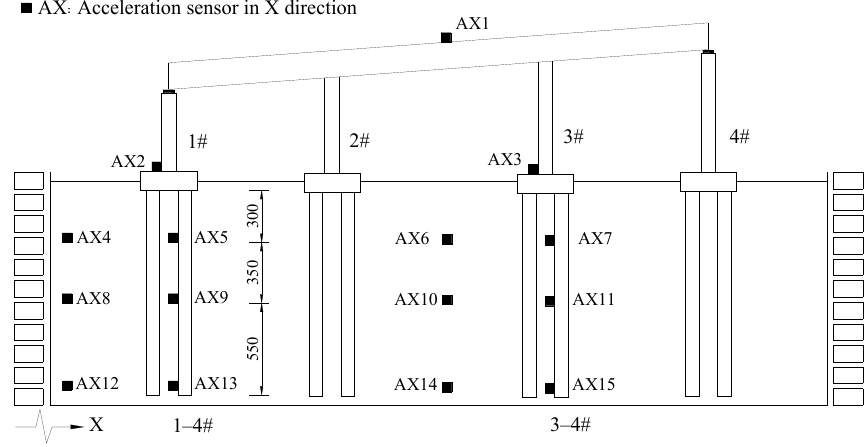
Figure 6. Layout of the acceleration sensors (unit: mm).